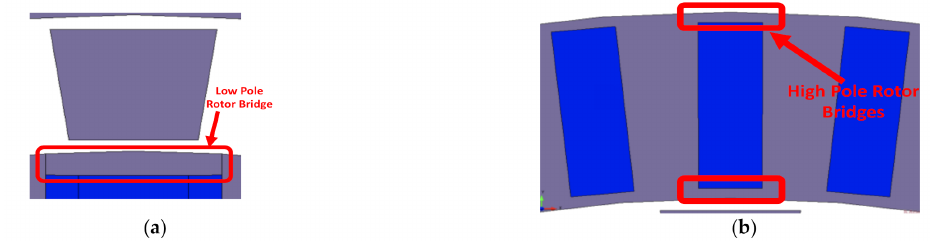
Figure 6. Magnetic bridges in the LPR and HPR; ( a ) LPR bridge; ( b ) HPR bridge.